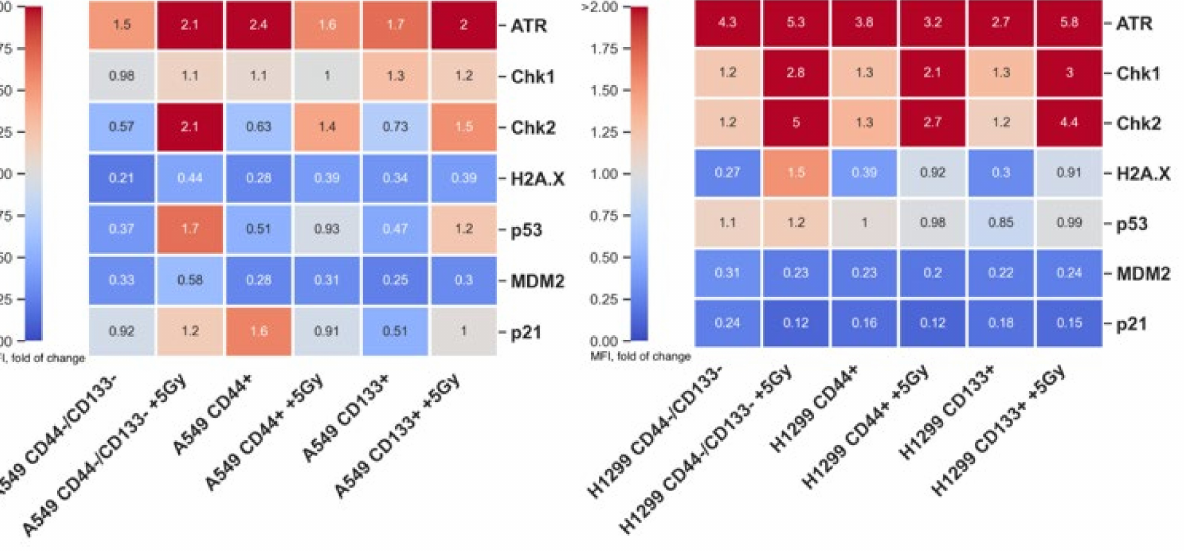
Figure 5. MILLIPLEX ® MAP 7-plex DNA Damage/Genotoxicity Magnetic Bead Panel analytes were detected in CD-sorted populations of A549 and H1299 cell lines 1 h after 5 Gy irradiation. Median Fluorescent Intensities (MFIs) are reported as fold change over the positive control (A549 cells stimulated with 5 µ M camptothecin) provided by the